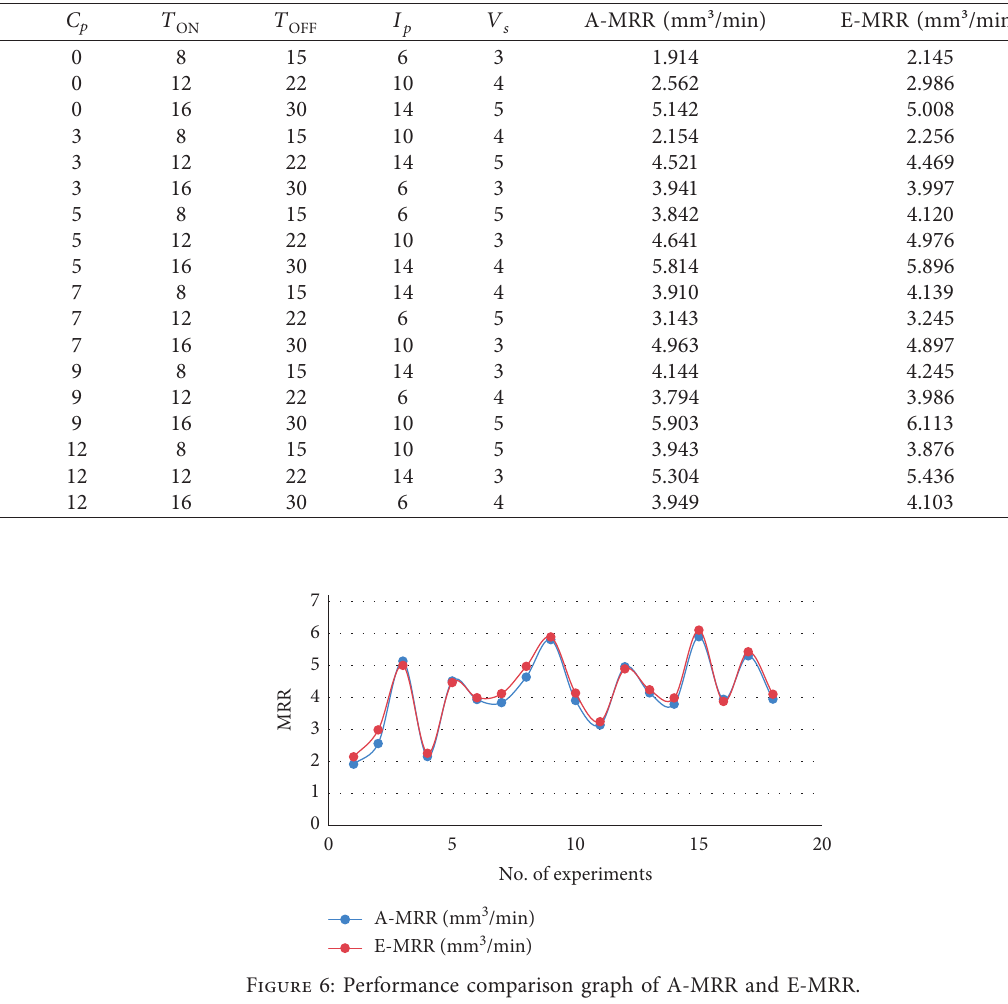
Table 6: Obtained values of A-MRR, E-MRR, and Ra.